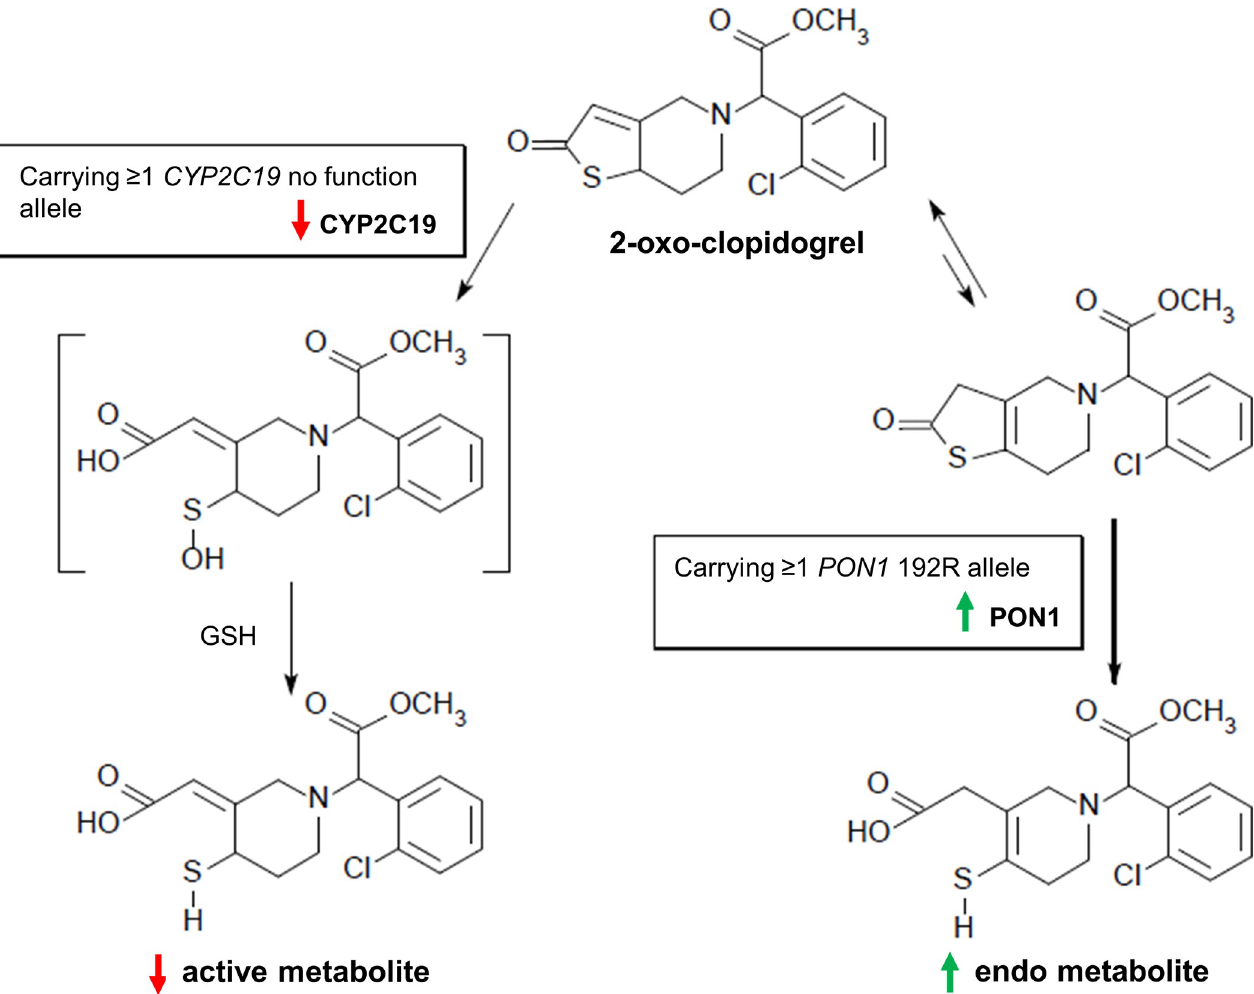
Fig 1. Pathway involved in the formation of the active and endo metabolites of clopidogrel in patients with polymorphisms in cytochrome P450 family 2 subfamily C member 19 ( CYP2C19) and paraoxonase-1 ( PON1 ). In carriers of � 1 PON1 192R allele, high PON1 activity may accelerate an increase in the production of the endo metabolite of clopidogrel. Low CYP2C19 activity in carriers of � 1 CYP2C19 no function allele may reinforce this cascade via the delayed metabolism of 2-oxo-clopidogrel into an active metabolite, which allows PON1 to metabolize 2-oxo-clopidogrel into the endo metabolite of clopidogrel. GSH,